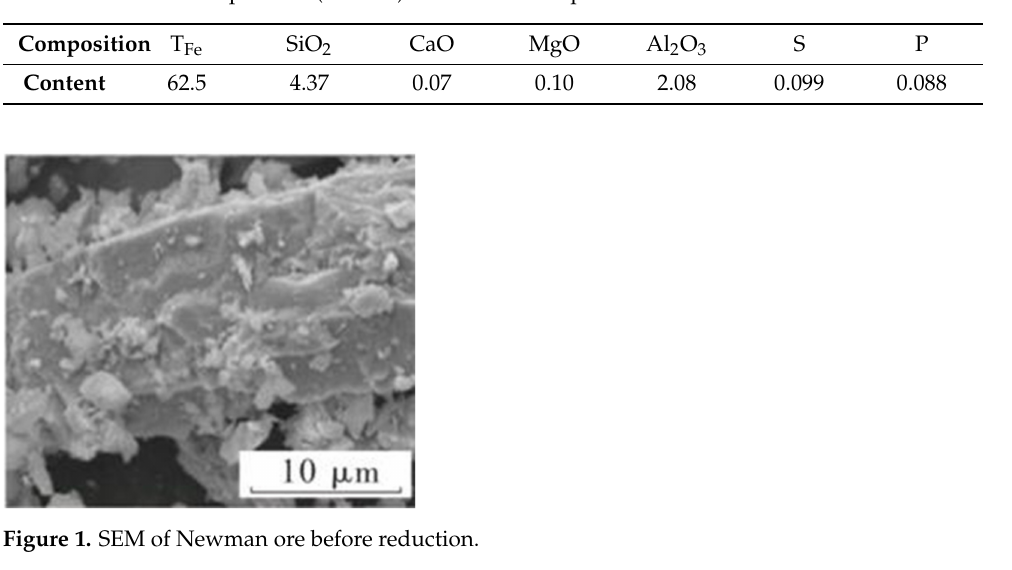
Table 1. Chemical composition (mass %) of Newman ore powder in Australia.